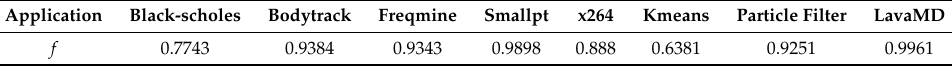
Table 3. The fitted parallel fraction values of each application.